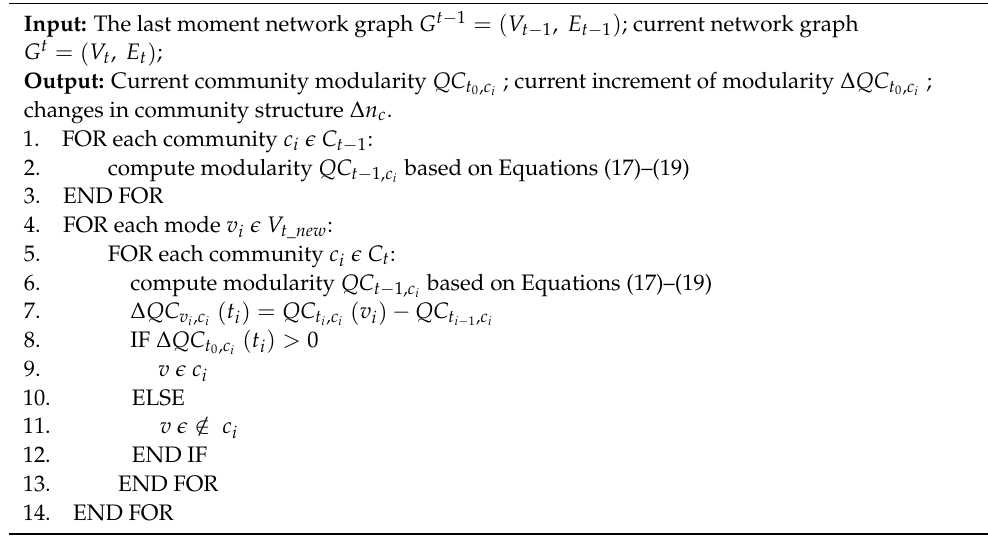
Algorithm 4 Locate the changing community structure